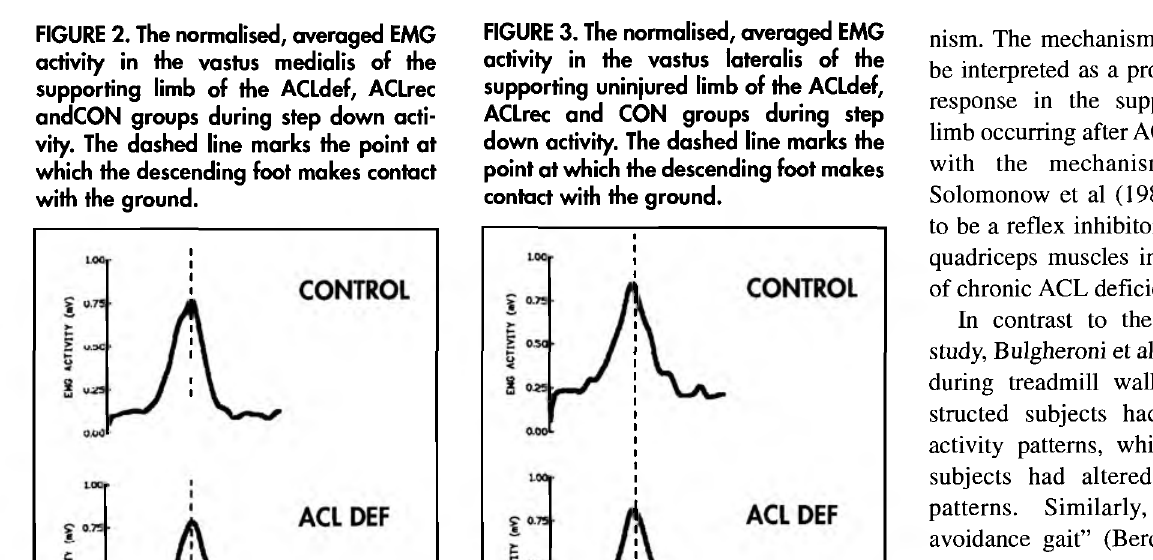
FIGURE 2. The normalised, averaged EMG activity in the vastus medialis of the supporting limb of the ACLdef, ACLrec andCON groups during step down acti­ vity. The dashed line marks the point at which the descending foot makes contact with the ground.